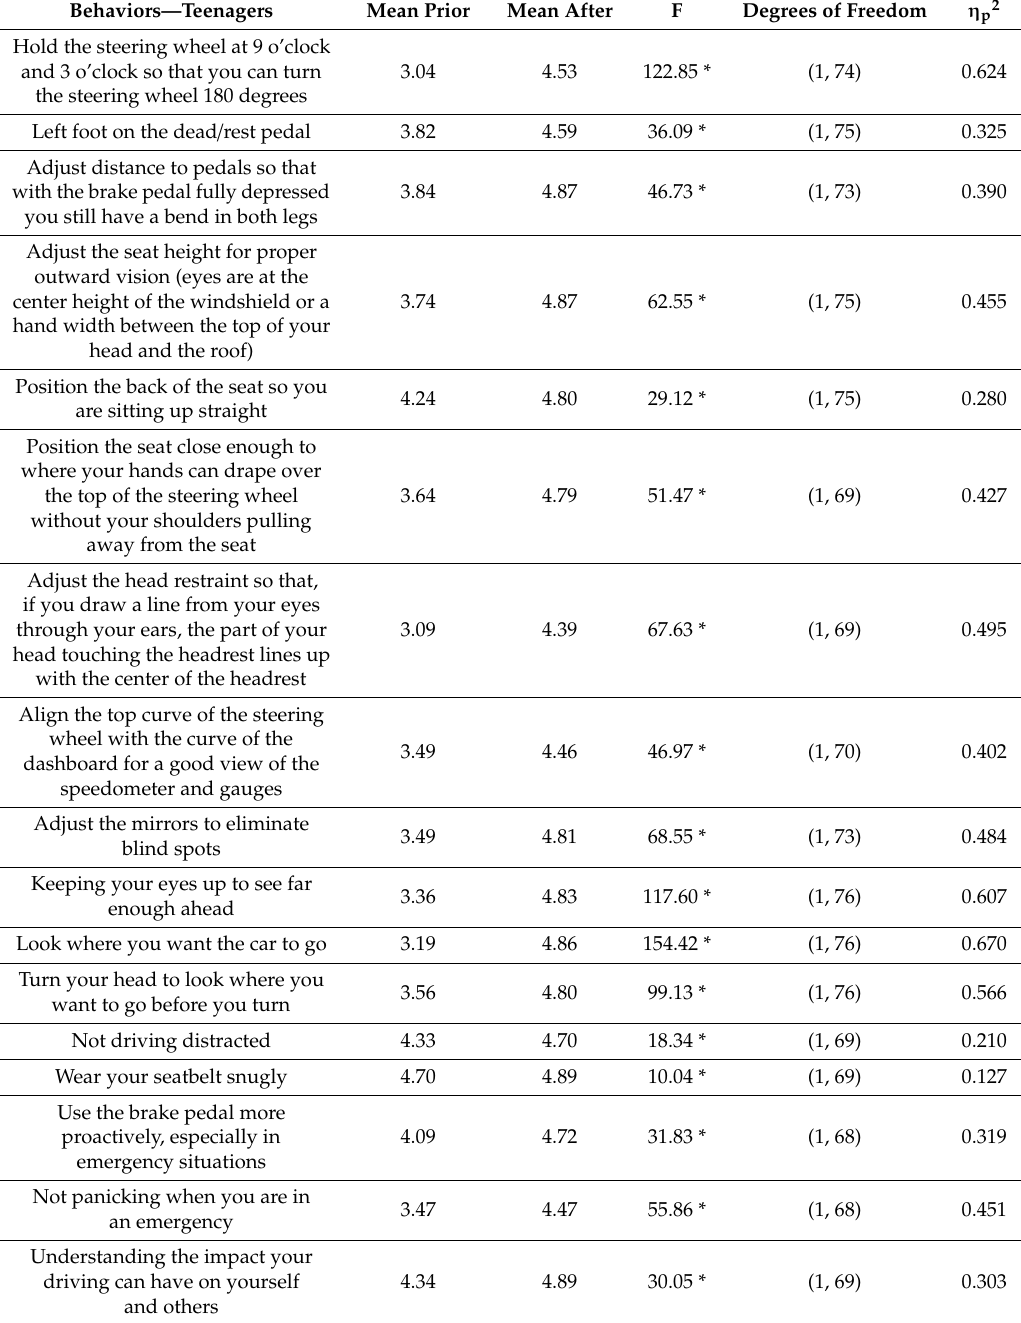
Table 4. Teenager survey participants’ average rating of the frequency to exhibit behaviors prior to the class and directly after the class. The asterisk designates significant di ff erences ( p < 0.05). Behaviors—Teenagers Mean Prior Mean After F Degrees of Freedom η p2